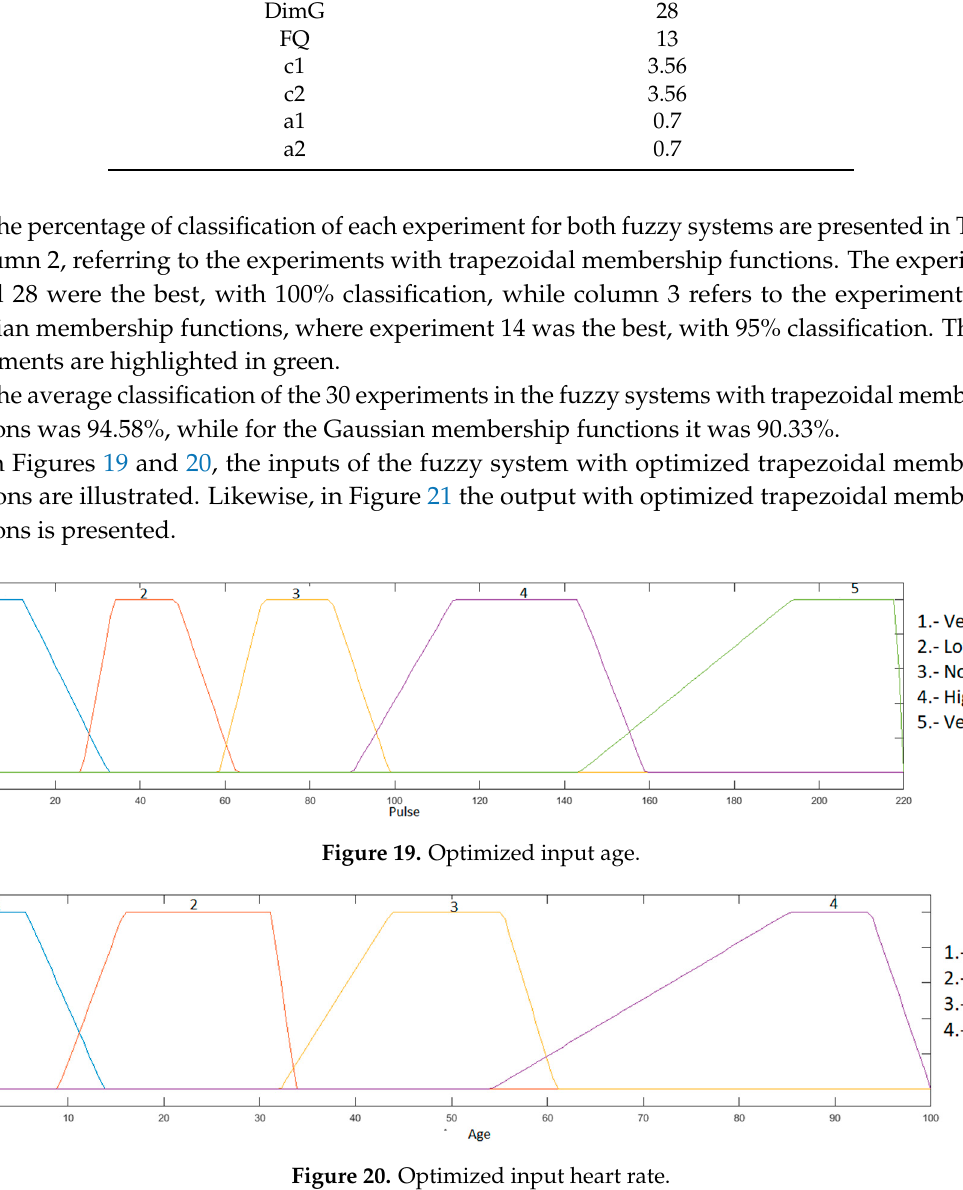
Figure 21. Optimized output heart rate level. In Figure 19 and Figure 20, the inputs of the fuzzy system with optimized trapezoidal membership functions are illustrated. Likewise, in Figure 21 the output with optimized trapezoidal membership functions is presented. In the same way, in Figure 22 and Figure 23 the inputs of the optimized fuzzy system with Gaussian membership functions are presented. In Figure 24, the output of the optimized fuzzy system with Gaussian membership function is presented. In both cases, the adjustment in each of the membership functions accomplished with the BSA can be observed. Figure 22. Optimized input age with Gaussian MFs. Figure 23. Optimized input heart rate with Gaussian MFs.